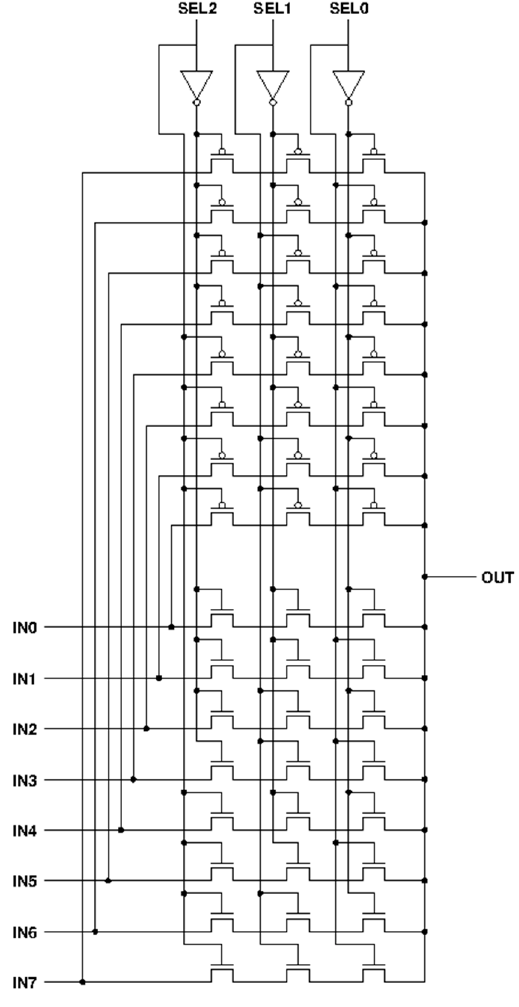
Figure 2. The 8:1 analog MUX.